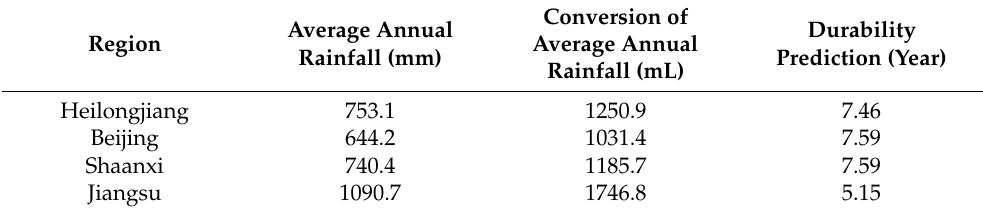
Table 5. Durability prediction of deicing agent in different